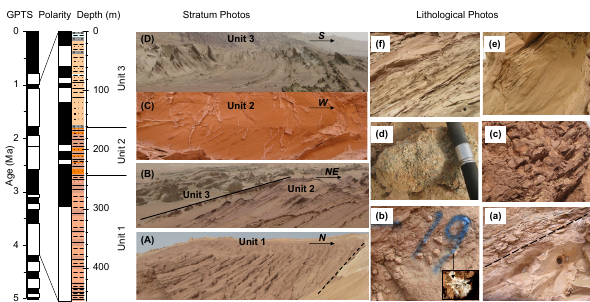
Fig. 2. Stratigraphy and magnetostratigraphy (Sun D. et al., 2011a) of the HBS Section. The lithology types of the strata are the same Fig.2 as in Fig.